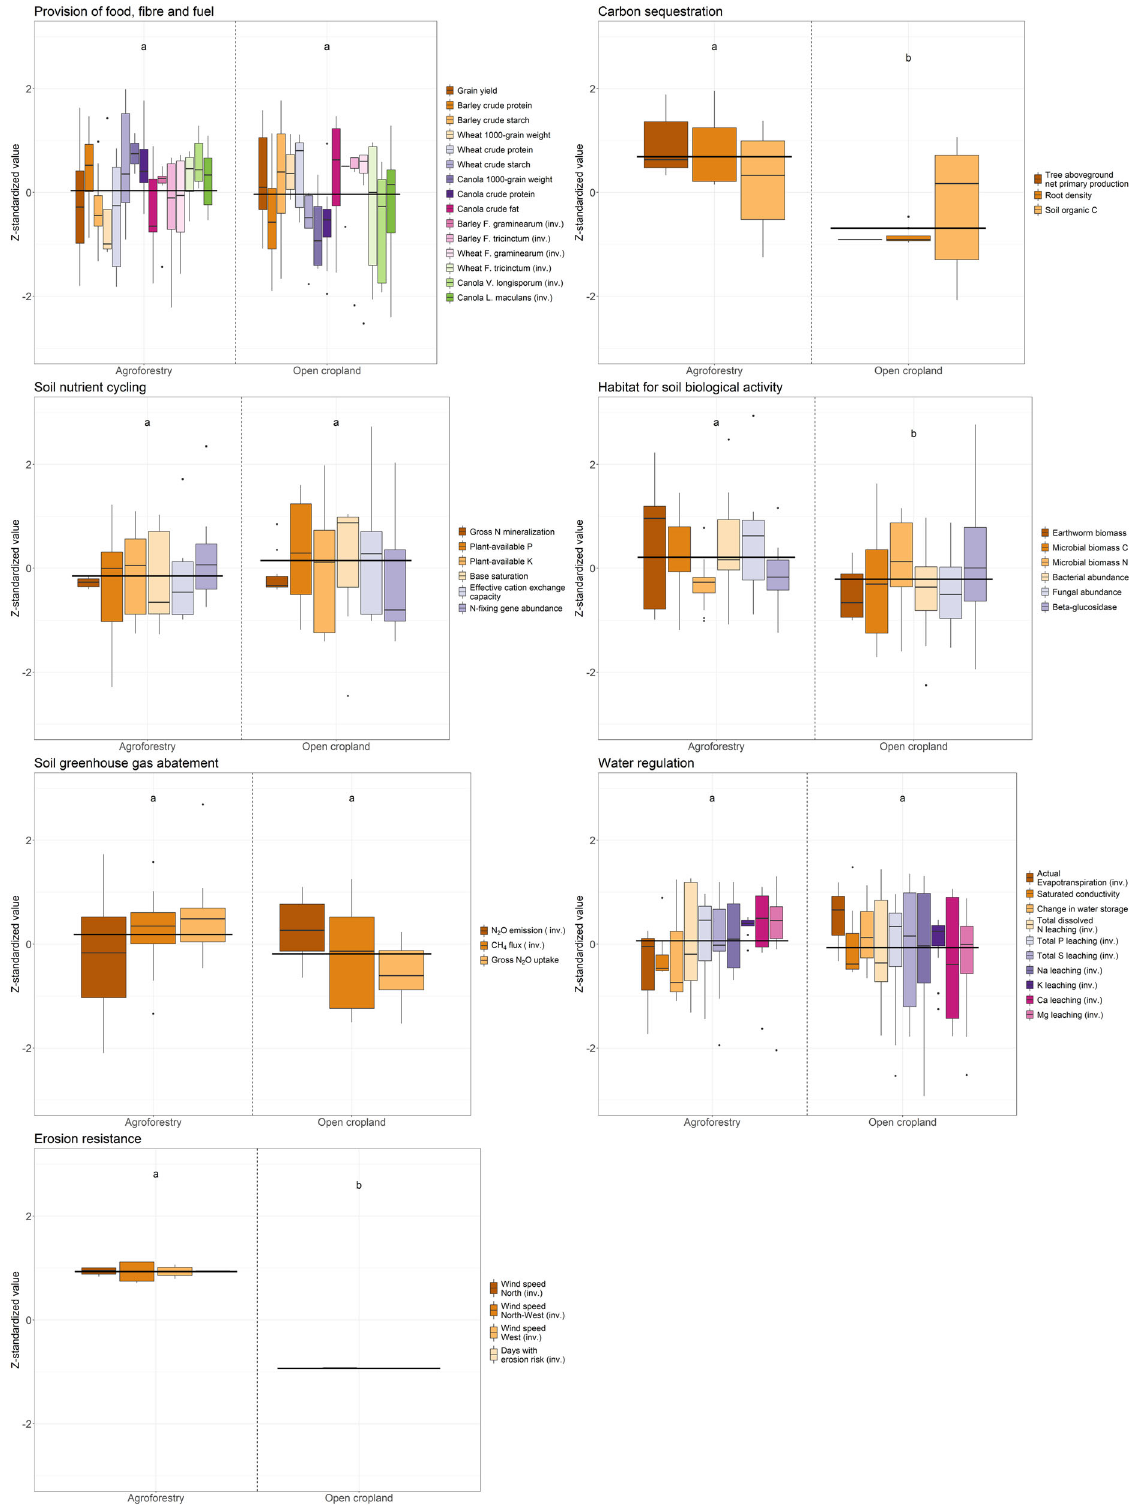
Fig. 1 Ecosystem functions and their indicators in cropland agroforestry and open cropland, measured at three sites in Germany. Each indicator is z - standardized: (actual value − mean value across replicate plots and sites)/standard deviation. Standardized values were inverted (inv.) for indicators of which high values signify undesirable effect (i.e., grain pathogen abundance, soil greenhouse gas fl uxes, nutrient leaching, wind speed). The black horizontal line indicates the mean of the standardized values of the indicators for a speci fi c ecosystem function. Boxplots indicate the 25th quartile, median and 75th quartile, and whiskers are 1.5 times the interquartile range. Mean, standard error and N values of indicators are given in Supplementary Table 4. For each ecosystem function, different letters indicate signi fi cant differences between cropland agroforestry and open cropland (linear mixed effects models at P ≤ 0.05; Supplementary Table